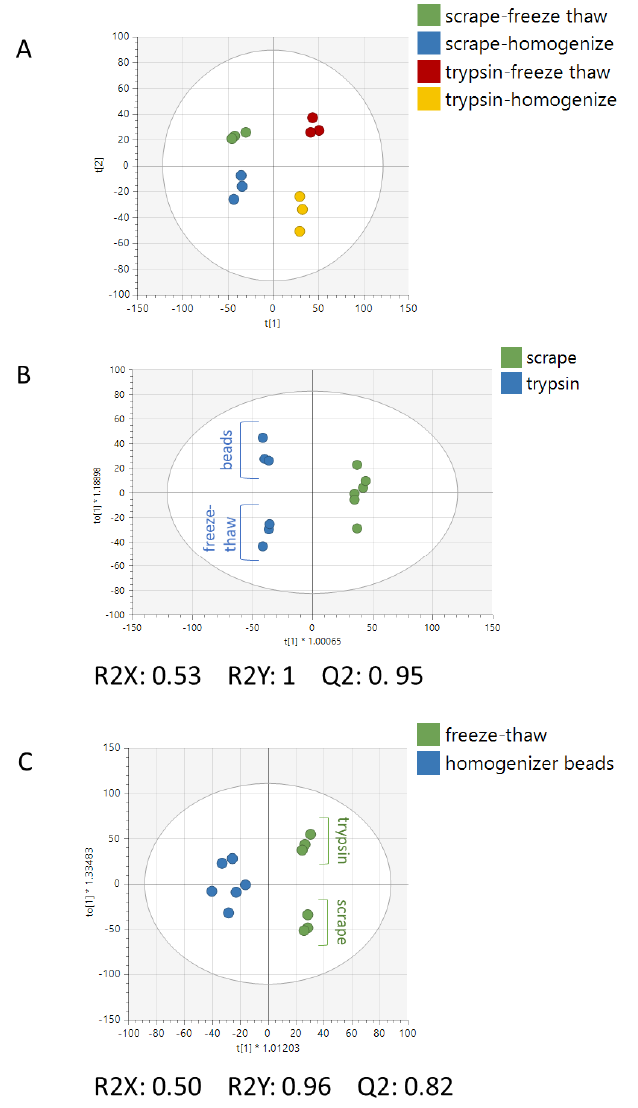
Figure 2. Multivariate analysis of the extracted cell samples. ( A ) PCA of all samples showing sep- aration of different detachment and lysis methods. ( B ) OPLS-DA of all trypsinized samples versus all cell-scraped samples. Sub-splitting can be seen between the bead and freeze–thaw lysis methods, particularly in the trypsinized samples. ( C ) OPLS-DA of all freeze–thawed samples versus all bead- homogenized samples. Sub-splitting can be seen between the bead and freeze–thaw lysis methods, particularly in the freeze–thawed samples. Pathway analysis was performed to identify the biochemical pathways that were sig- nificantly different between the detachment and lysis methods. Peak intensity tables were imported into MetaboAnalyst’s “Functional Analysis” module to compare the trypsinized